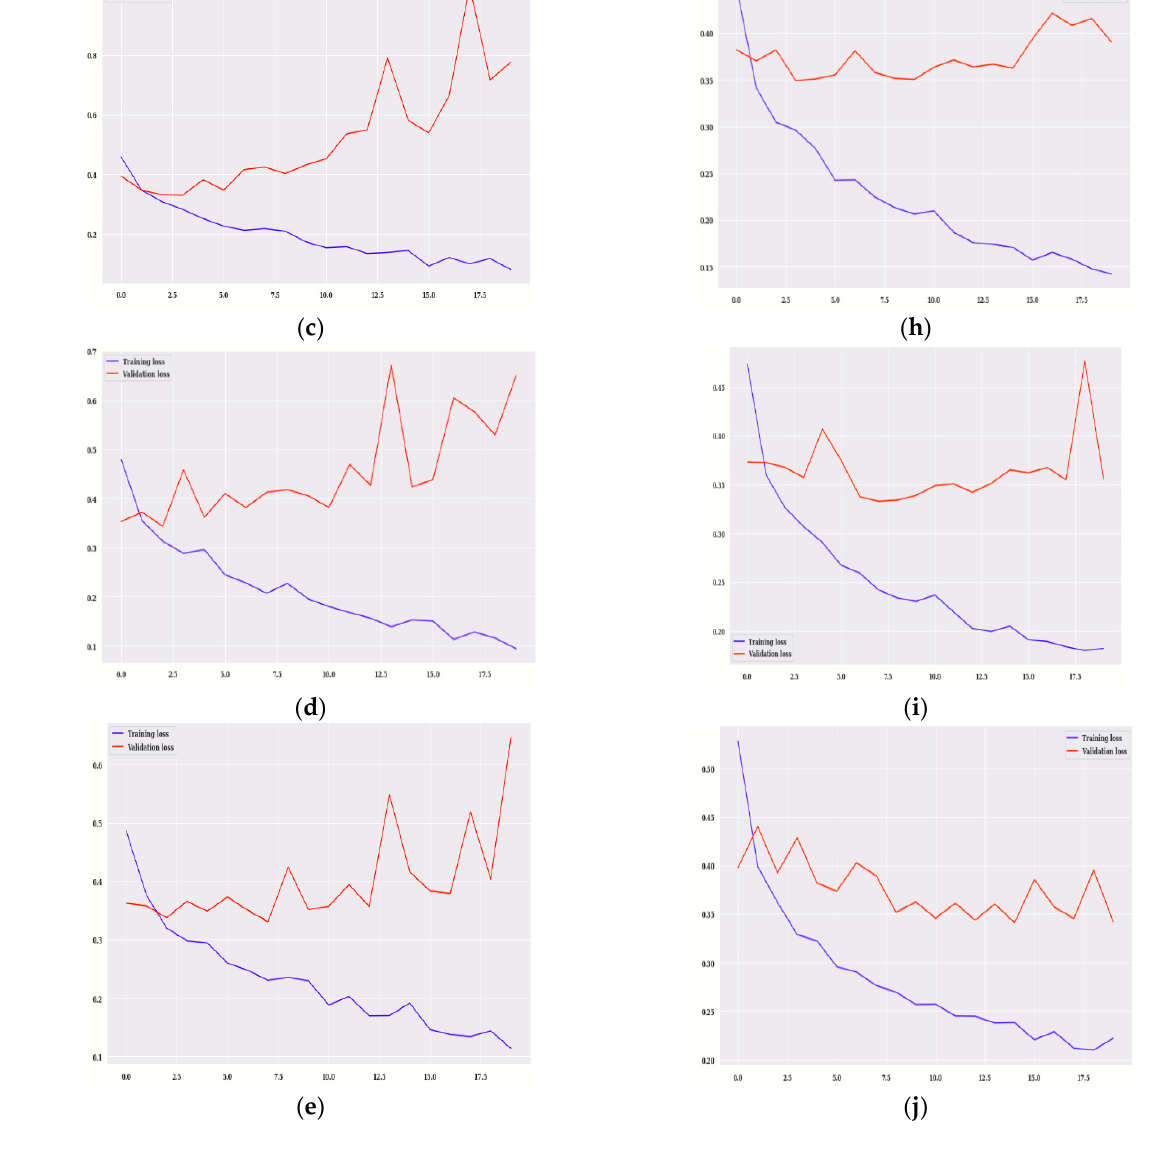
Figure 7. Training Loss for VGG16 on Batch Size ( a ) 8 ( b ) 16 ( c ) 32 ( d ) 64 ( e ) 128, Training Loss for Modified VGG16 ( f ) 8 ( g ) 16 ( h ) 32 ( i ) 64 ( j ) 128.